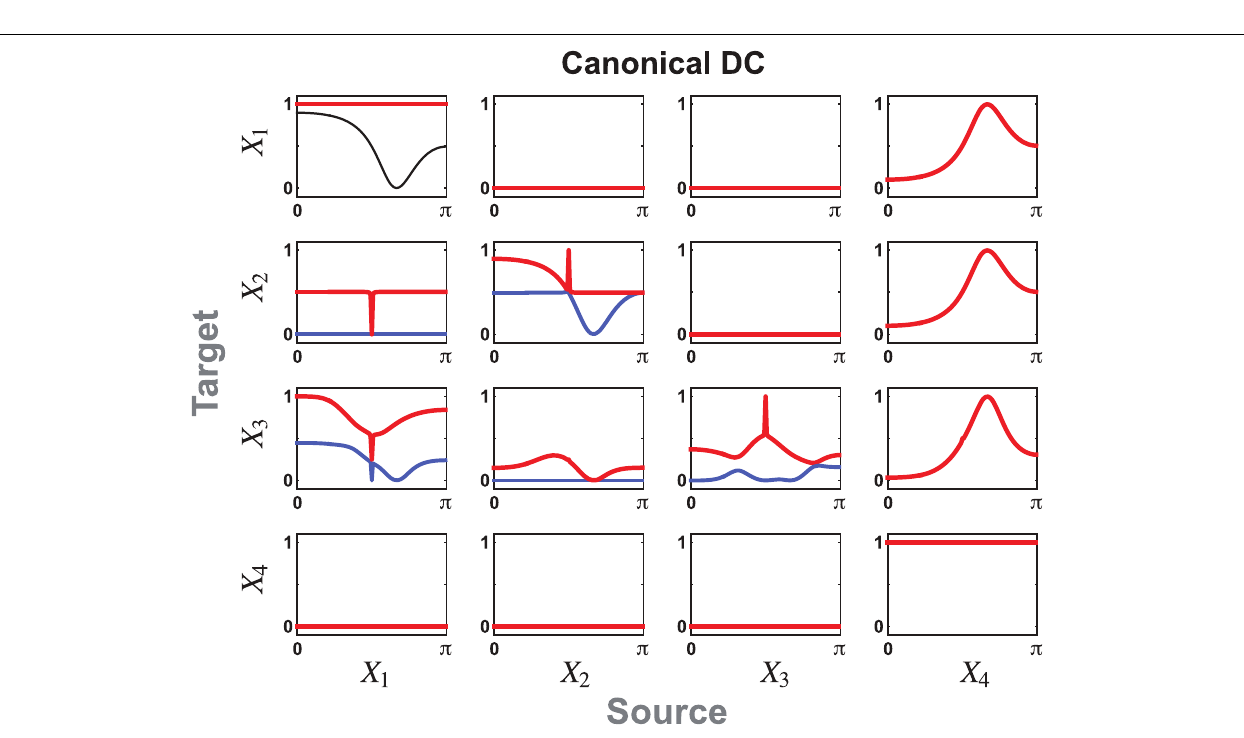
FIGURE 6 | cDC for Example 2 with a = 1 which differs from Figure 5 in the effect from X 4 to X 3 which no longer cancels